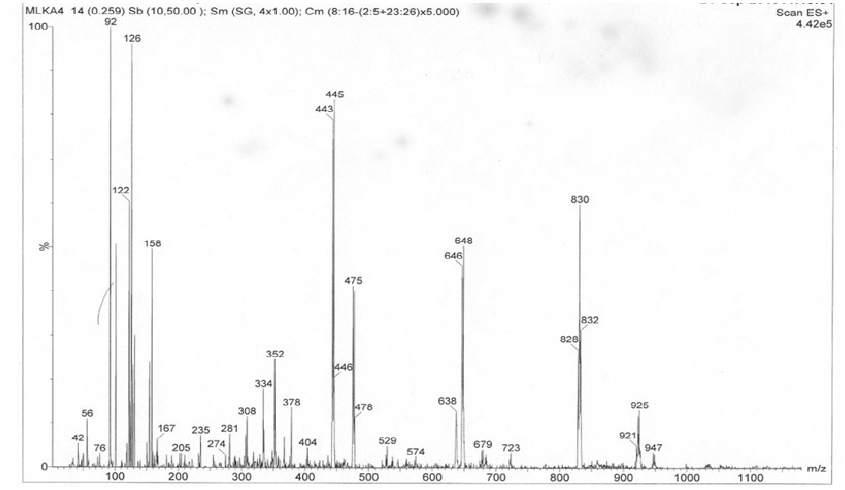
Figure 7. Mass spectrs of Co(II) complex